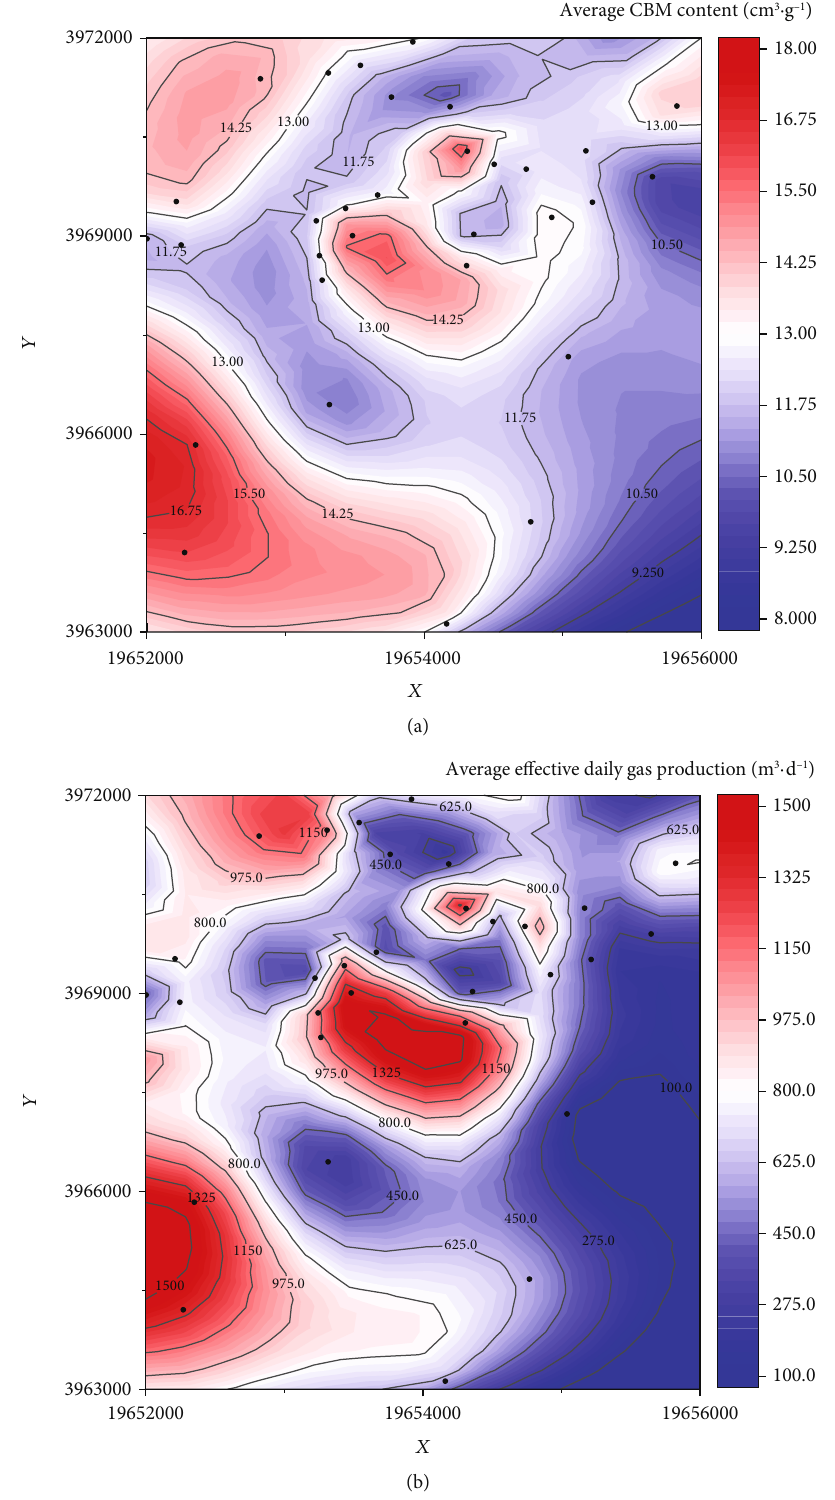
Figure 20: (a) Contour map of CBM content of the 3 # coal seam in Southern Shizhuang block (eastern area); (b) contour map of the average e ff ective daily gas production from the 3 # coal seam in the Southern Shizhuang block (eastern